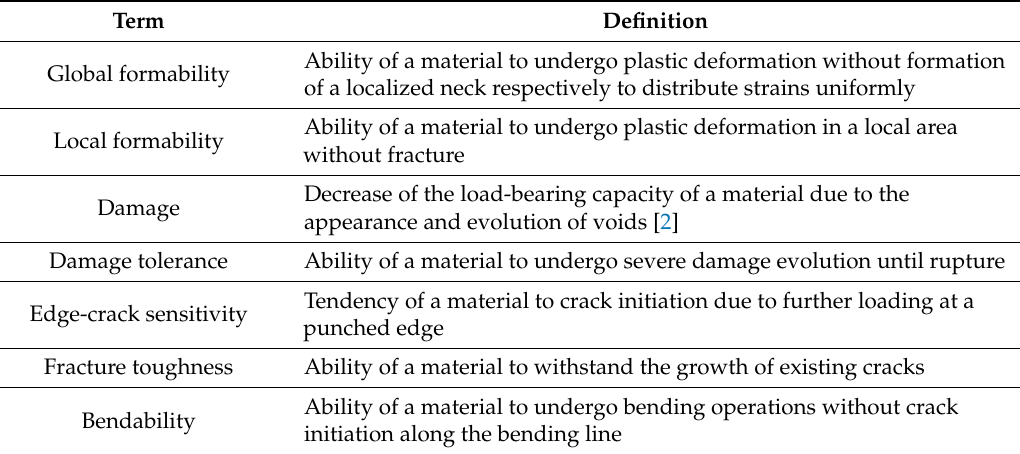
Table 1. Definition of terms regarding the mechanical properties related to fracture behaviour of high-strength multiphase steels.